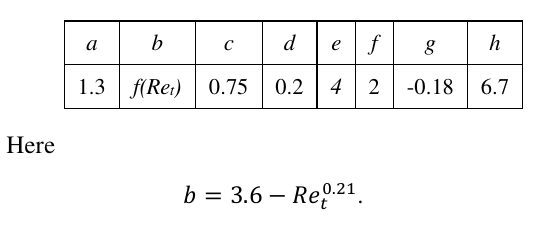
Table 3. Parameters of the current model.